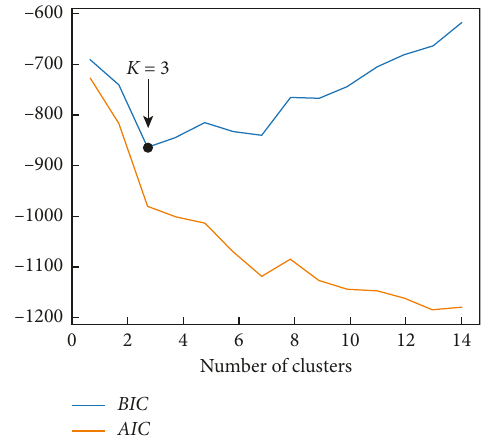
Figure 5: Selection of the best number of clusters.